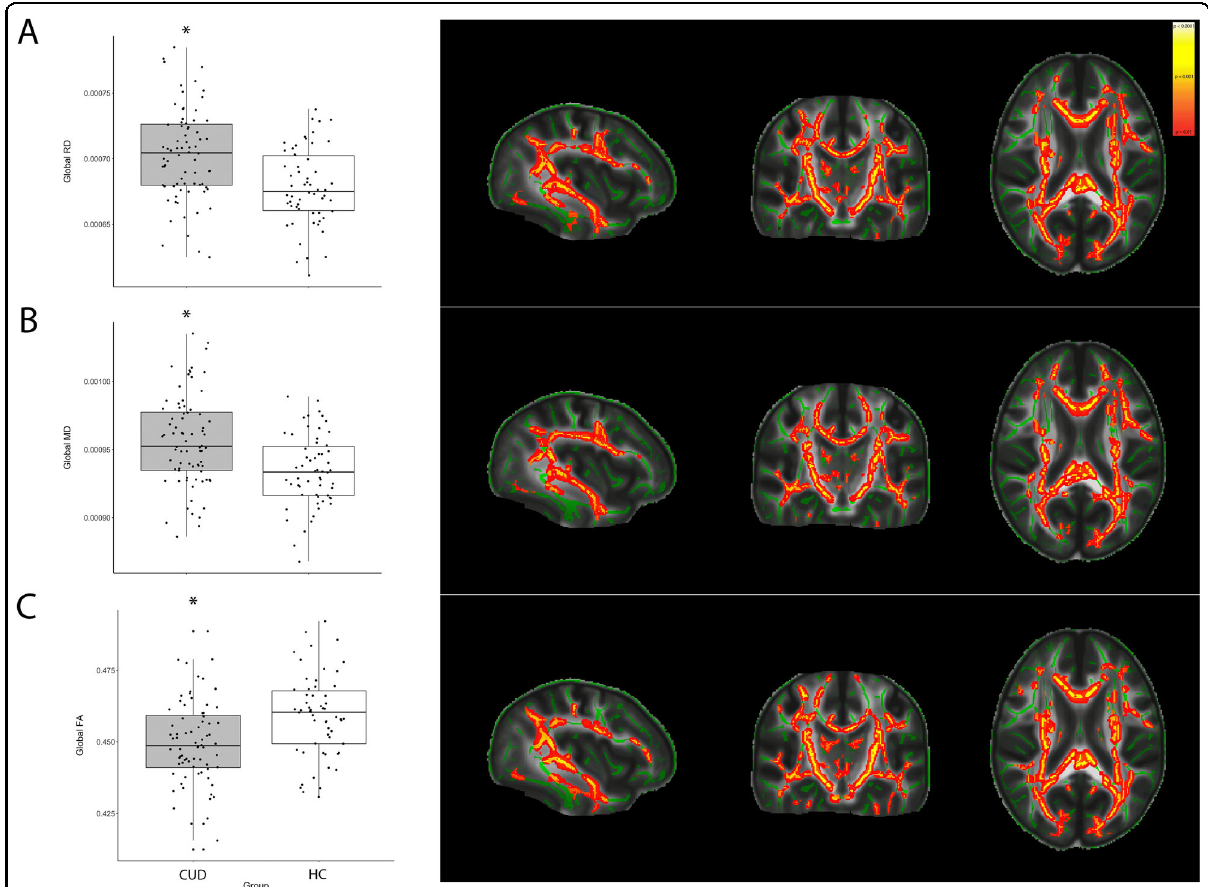
Fig. 1 Boxplots for global DTI metrics in patients with CUD and HCs and the results from the TBSS analysis. Green line represents major white matter tracts projected on the average FA image; orange/red heat scale shows that the voxels with signi fi cant differences ( p < 0.01, corrected for multiple comparisons) have different DTI metrics between the groups. Coronal view: y = 110; axial view: z = 92. A Higher RD values were observed in patients with CUD compared with HCs, both in the TBSS analysis and whole-brain average ( p < 0.01). B Higher MD values were observed in patients with CUD compared with HCs, both in the TBSS analysis and whole-brain average ( p < 0.01). C Lower FA values were observed in patients with CUD compared to HCs, both in the TBSS analysis and whole-brain average ( p < 0.01). CUD cocaine use disorder, HC healthy control, DTI diffusion tensor imaging, TBSS tract-based special statistics, RD radial diffusion, MD mean diffusion, FA fractional